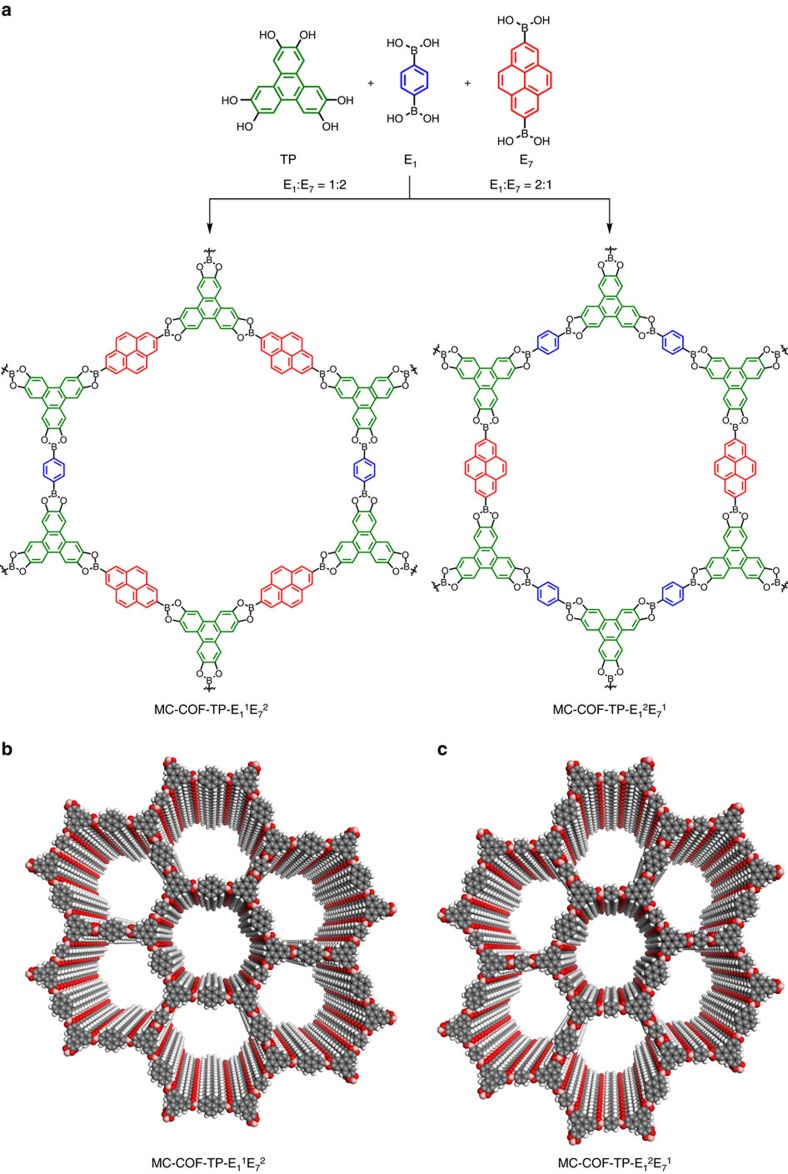
Synthesis and structures of typical [1+2] hexagonal MC-COFs.(a) Schematic representation of the synthesis of MC-COF-TP-E11E72 and MC-COF-TP-E12E71. (b) View of the slipped AA stacking crystal structure of MC-COF-TP-E11E72. (c) View of the slipped AA stacking crystal structure of MC-COF-TP-E12E71.